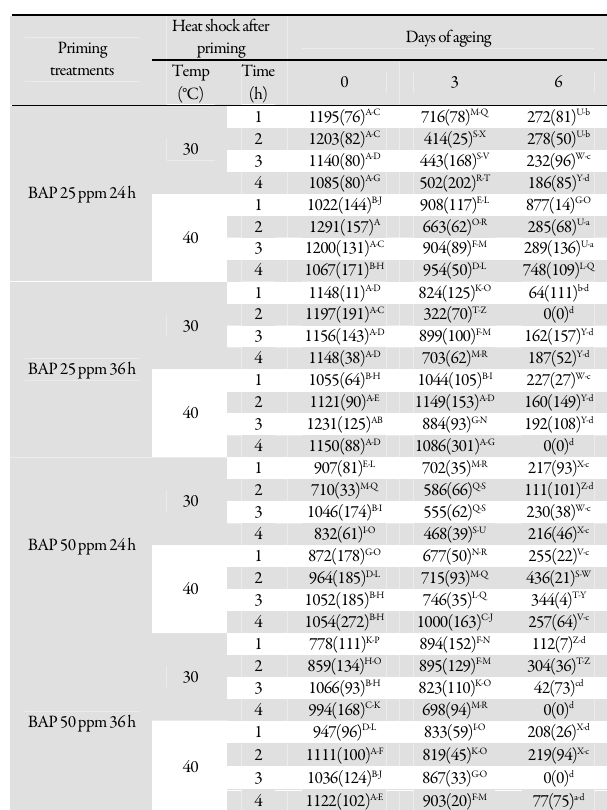
Tab. 3. Seedling vigour index (SVI) of Tall wheatgrass seeds at different levels of heat shock followed by priming treatments; the LSD0.05 for SVI is 174.32